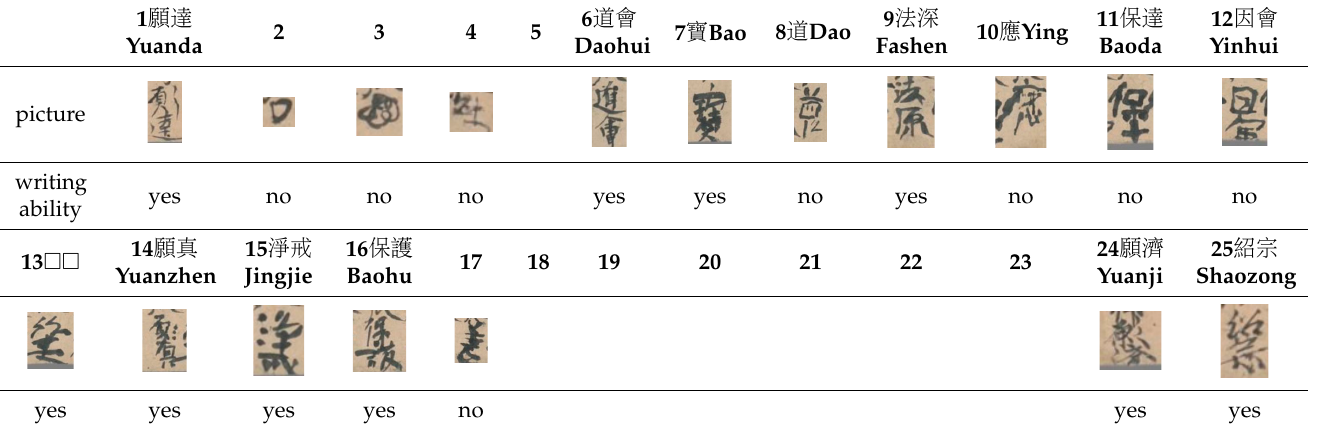
Table 5. Calligraphy of monks of Jingtu Monastery in 931.